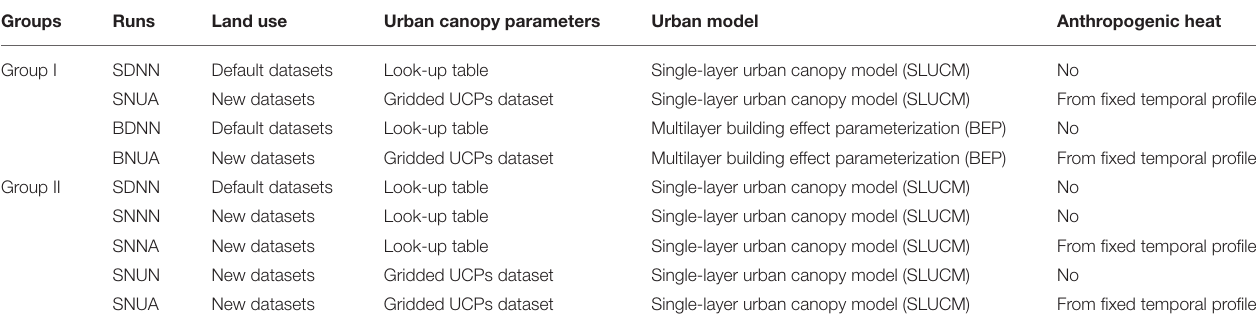
TABLE 2 | Overview of the simulation cases with difference configurations. Groups